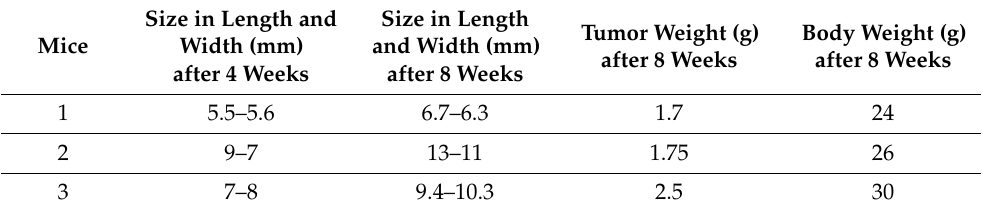
Table 3. Experimental and measurement details of the mice model used to determine the KAIMRC2 cell line’s tumorigenicity